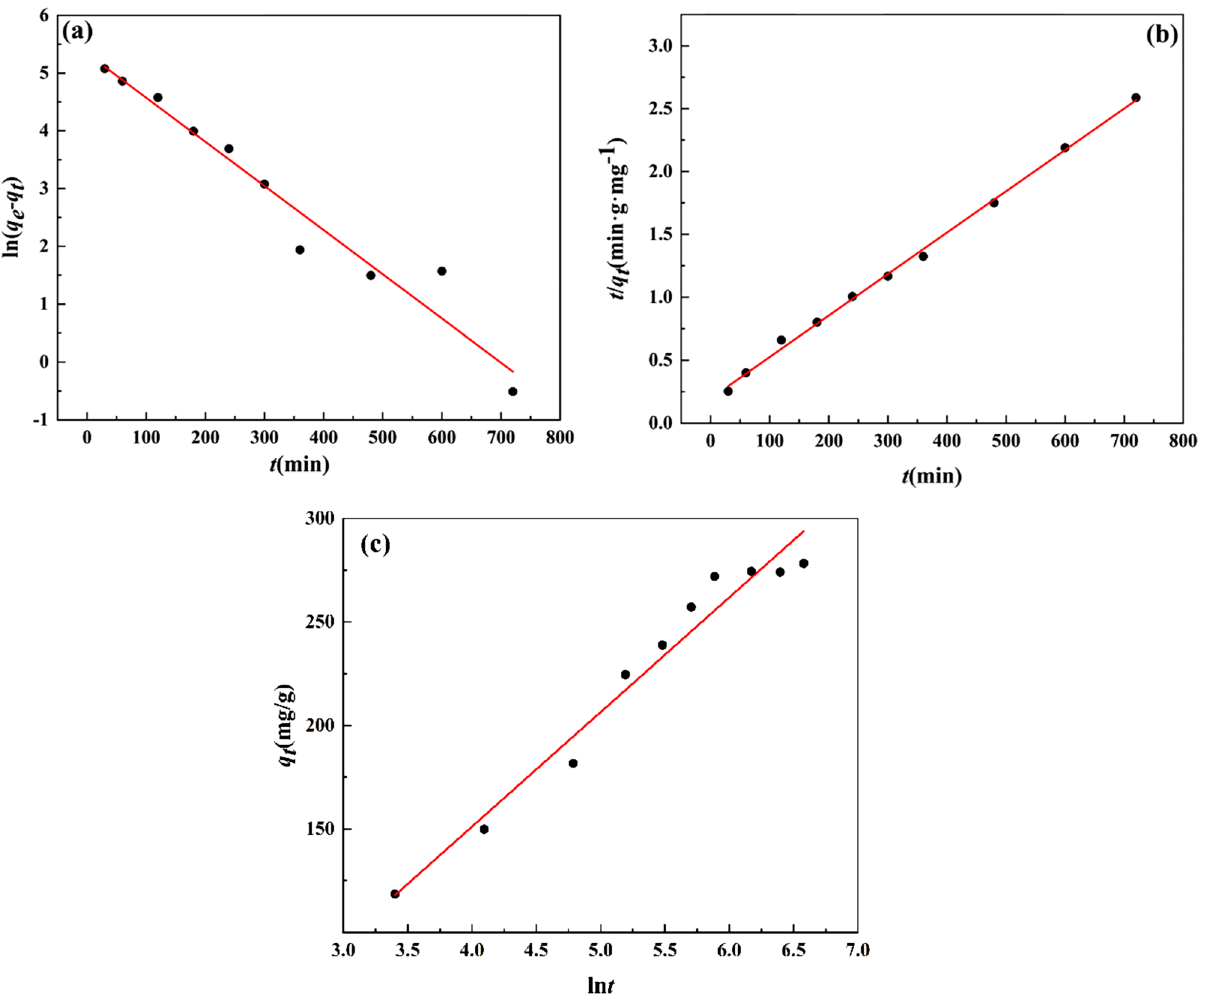
Figure 6. Pseudo-first-order kinetic model ( a ), pseudo-second-order kinetic model ( b ) and Elovich model ( c ) of U(VI) adsorption by ZnNiAl-LDHs.